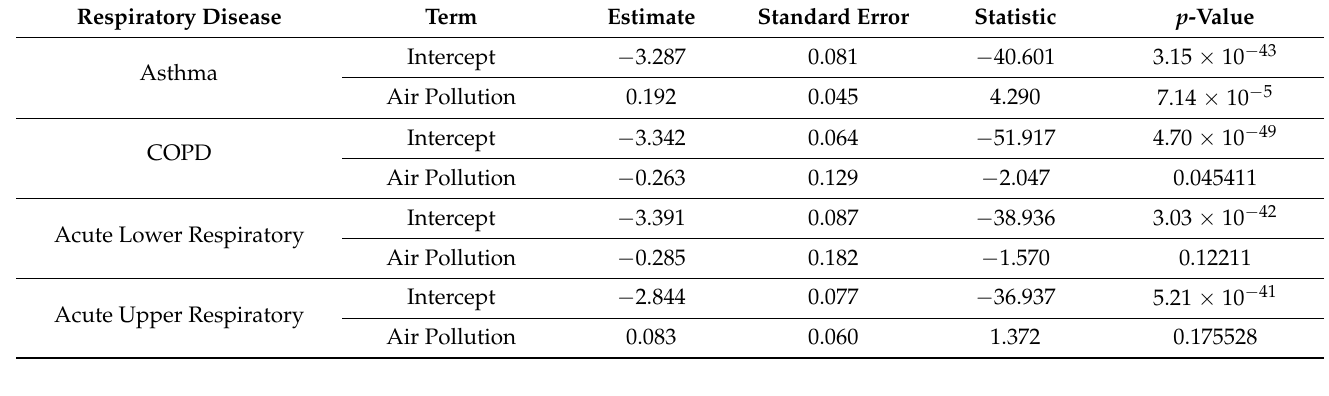
Table 2. The association between air pollution and respiratory diseases.